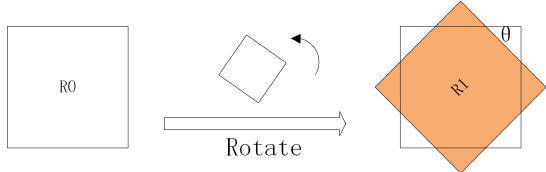
Figure 3. Two objects in opposite directions are prone to loss in NMS operations.